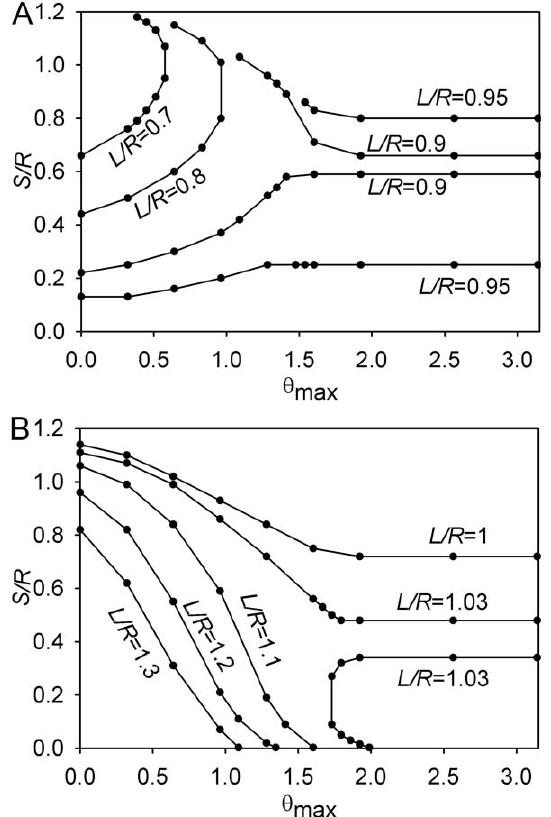
Figure 8. Symmetry instability domain. In the three-dimensional space of structural parameters ( h max , S/R , L/R ), L/R is understood as the vertical dimension in this figure. Isolines corresponding to the indicated values of L/R are shown. (A) Surface bounding the domain from below. (B) Surface bounding the domain from above. (These contour plots may be viewed as topographic maps. In A, symmetry is stable when the point representing the conditions of the individual cell lies below the mapped surface, and unstable otherwise. In B, symmetry is unstable when the point lies below the mapped surface, and stable otherwise.).